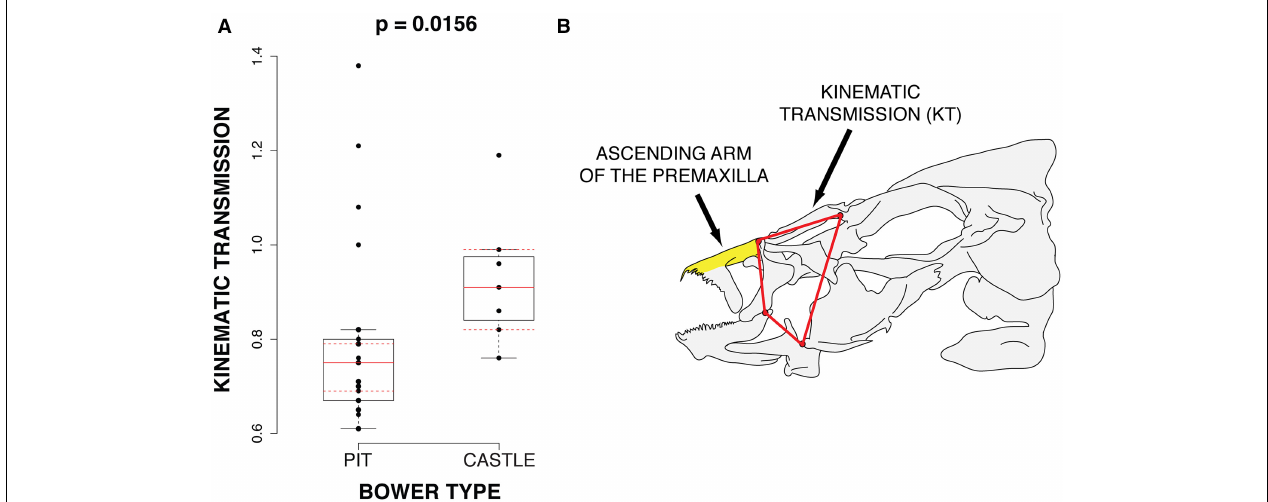
FIGURE 4 | Differences in functional jaw morphology. (A) 4-bar Kinematic transmission is significantly higher in castle-building species. (B) The cichlid anterior jaw. The ascending arm for the premaxilla and 4-bar linkage system (kinematic transmission) are labeled.